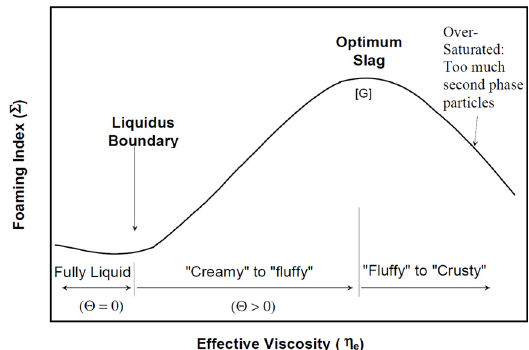
Figure 3: Relationship between the foaming index and effective viscosity.